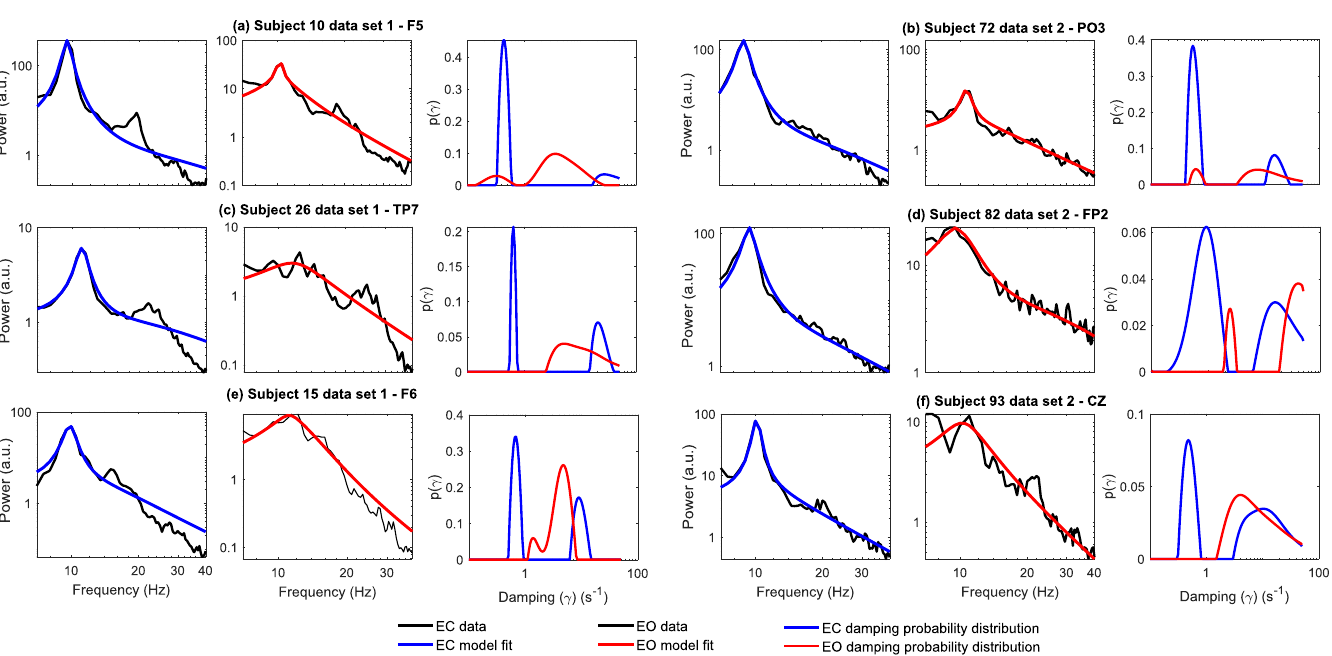
Fig 3. Example damping distributions for strong alpha blockers. (a-f) Damping distributions obtained from EC (blue) and EO (red) power spectra for six individuals (three per data set) who presented with strong alpha blocking. Plotted alongside the experimental power spectra are the respective model fits (EC—blue, EO—red) generated using the EC and EO damping distributions in the forward problem Eq 14. The inferred damping distributions are clearly bimodal in shape, a feature common across both data sets. The first mode of the EC damping distribution is generally peaked at a smaller damping value and has a larger respective area when compared to the EO